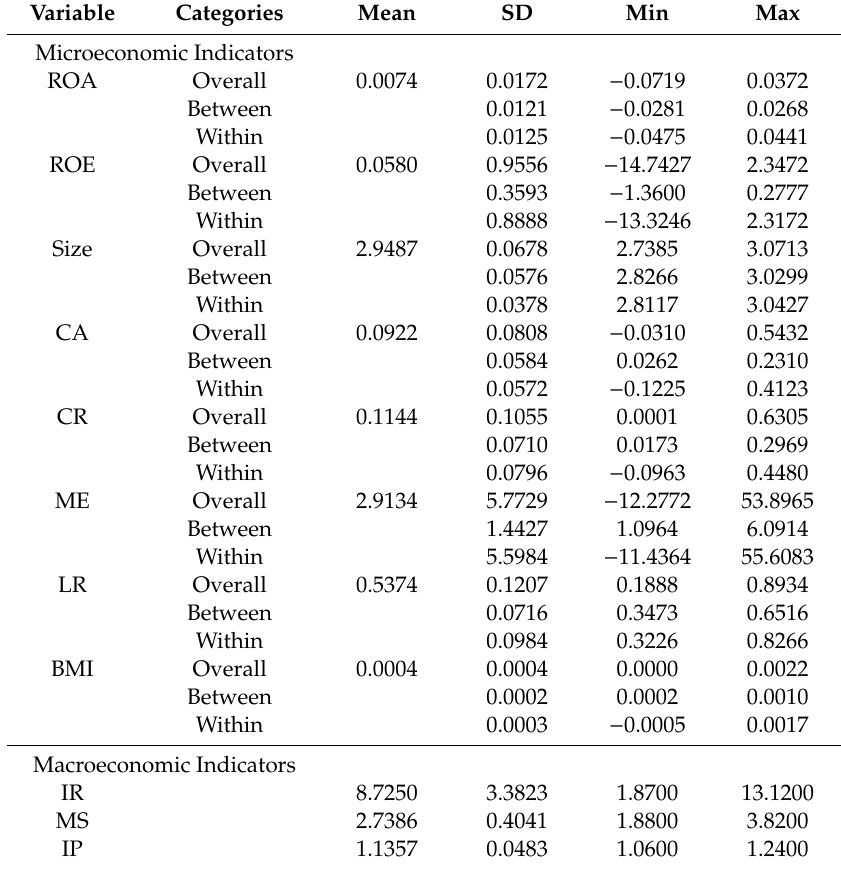
Table 1. Descriptive statistics (overall, between, and